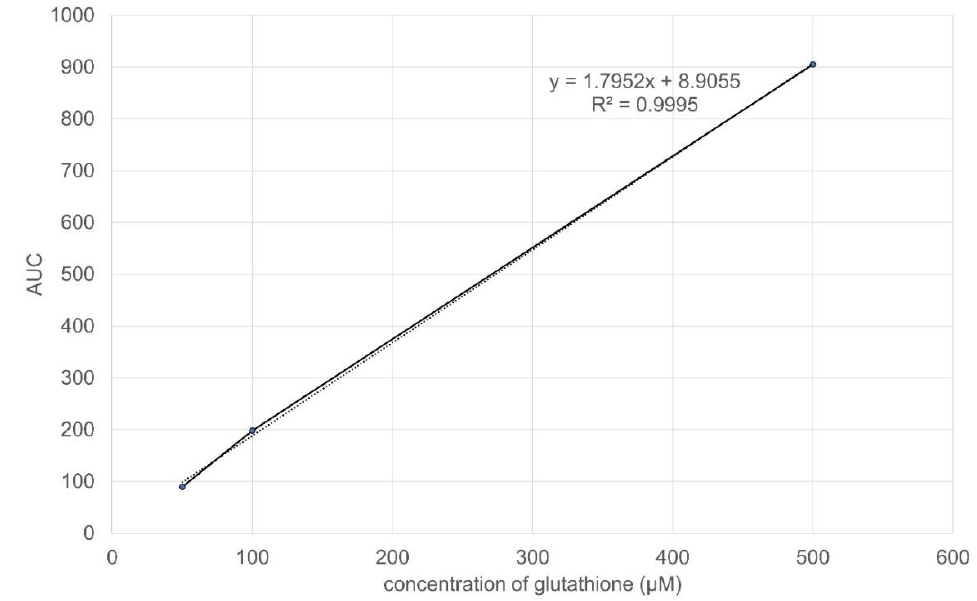
Figure A9. Calibration curve to determine the amount of glutathione in rat small intestine.